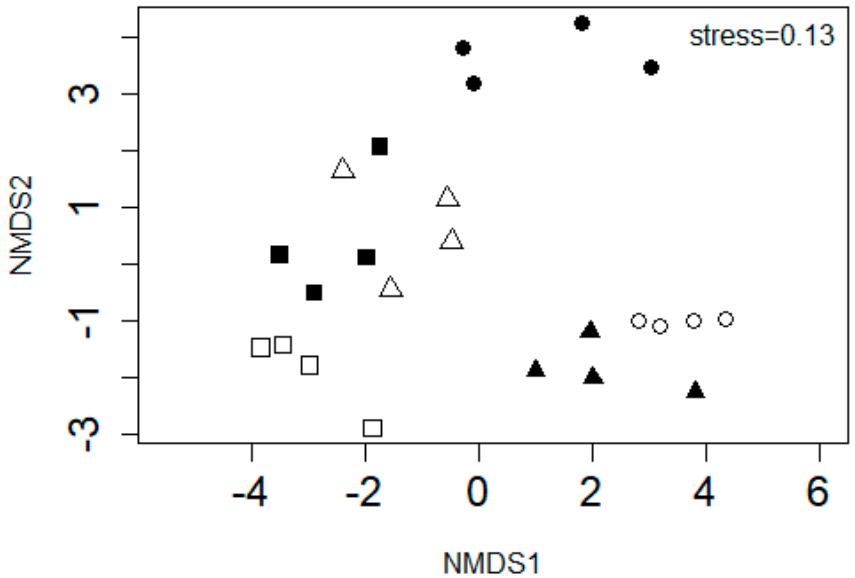
Figure 5. A non-metric multidimensional scaling plot ordinating the average score per taxon observed in Site 1 ( □ ), Site 2 ( ∎ ), Site 3 ( ∆ ), Site 4 ( ▲ ), Site 5 ( ○ ), and Site 6 ( ● ) in the Palmiet River.